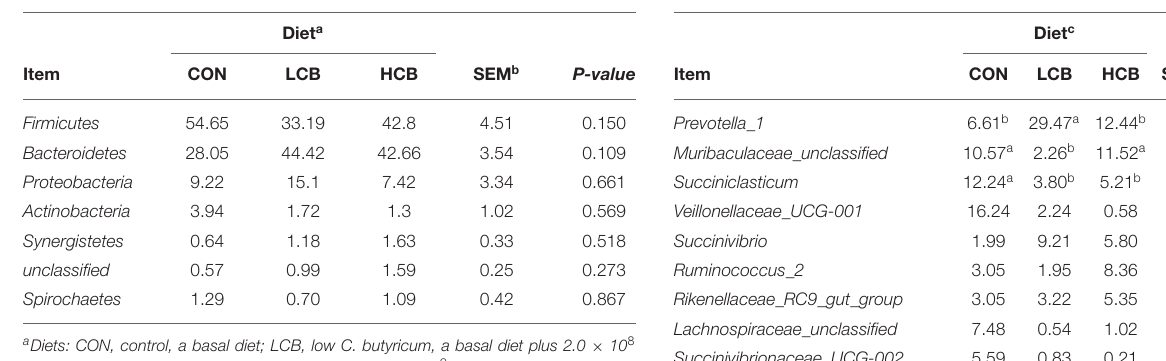
TABLE 7 | Effects of different doses of C. butyricum on genus relative rumen microbiota abundances ( > 1.0%) of fattening goats.